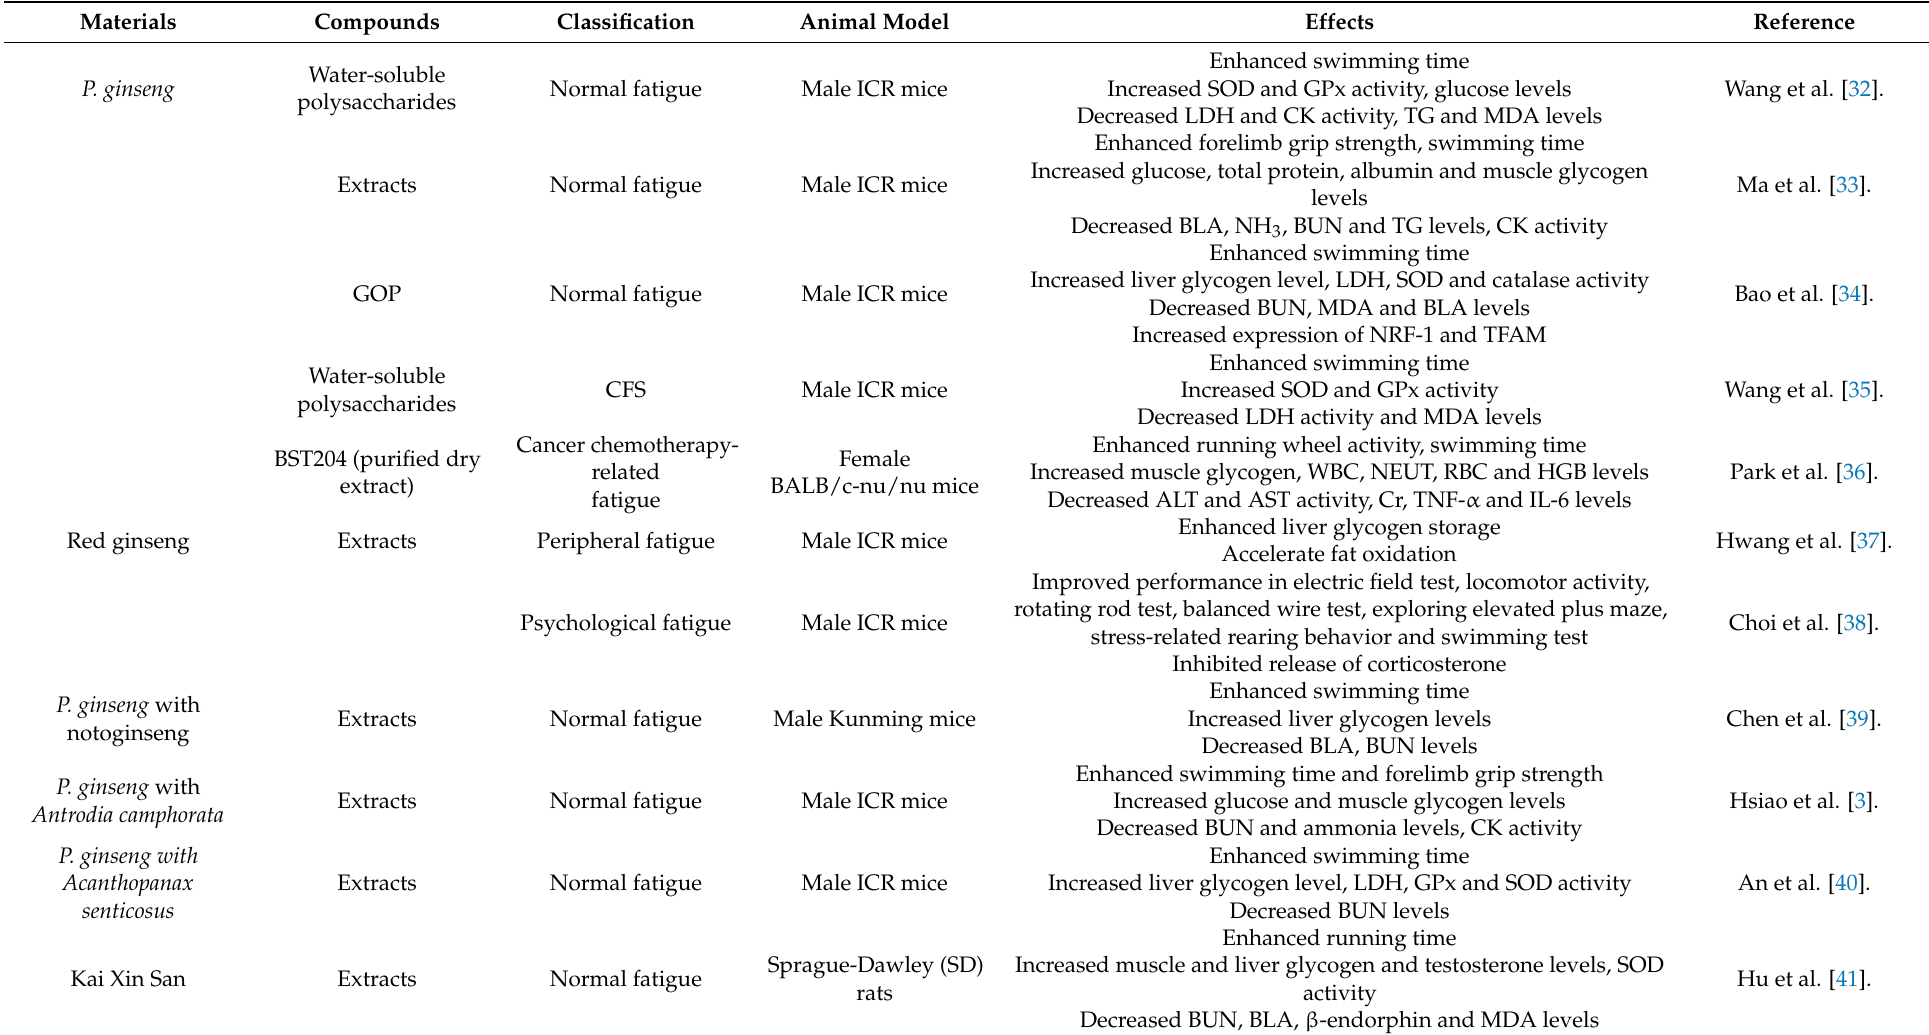
Table 1. Anti-fatigue effects of mixture extract from P. ginseng in animal